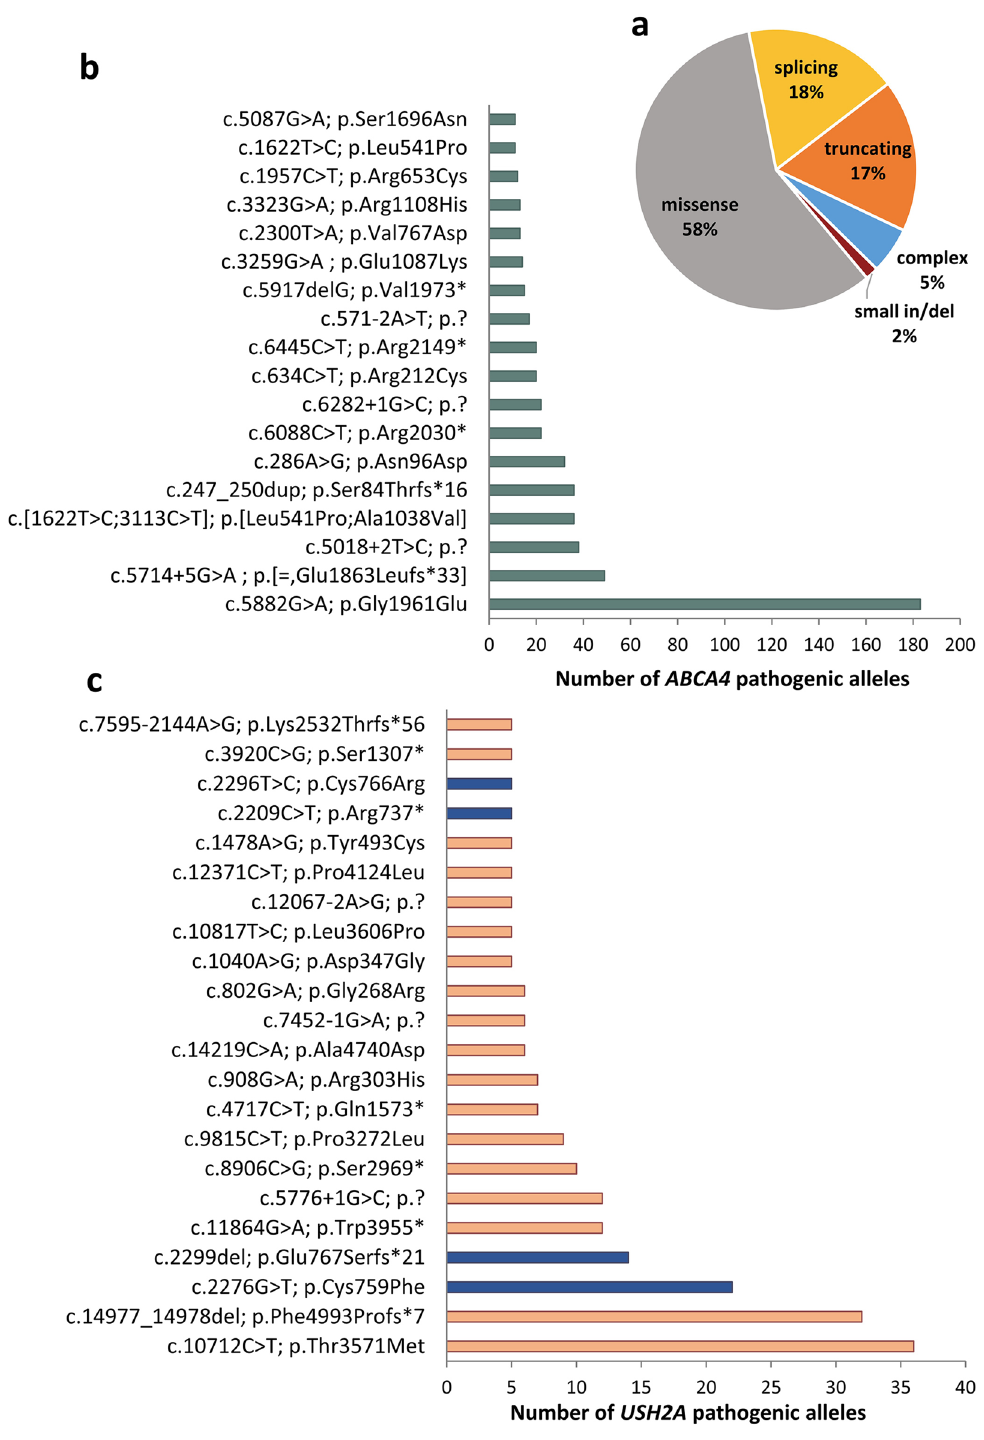
Figure 3. Most frequent variants identified in ABCA4 - and USH2A -associated cases. ( a ) Pie-chart showing the relative abundance of the different classes of variants across the ABCA4 pathogenic alleles. ( b ) Histogram showing the most frequent ABCA4 alleles. ( c ) Histogram of occurrence of the most recurrent USH2A variants. Blue bars show variants located in exon